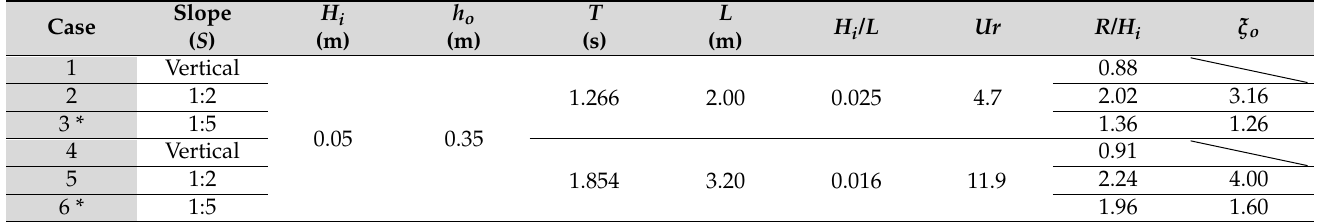
Table 1. Numerical conditions of the incident periodic wave and the numerical results of the wave